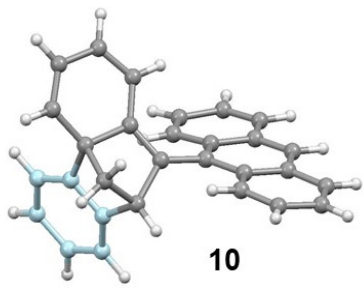
Figure 8. Molecular structure of benzyne adduct 37 .